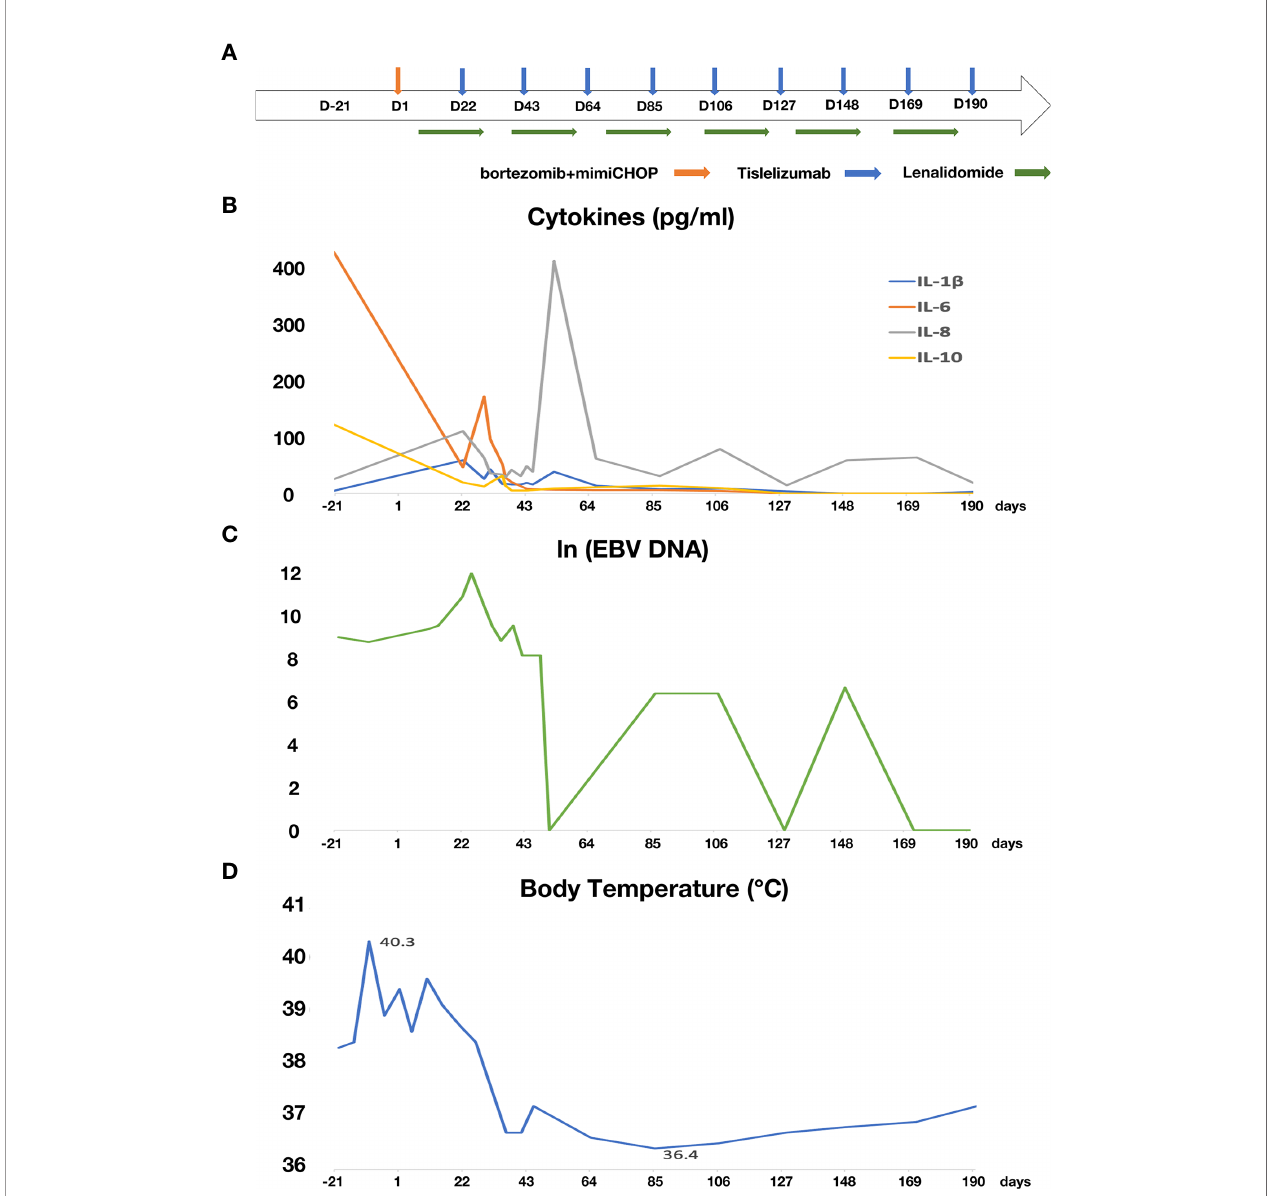
FIGURE 2 | The treatment schedule and the change of cytokines, serum EBV-DNA and body temperature of the patient. (A) Flow chart of treatment; (B) the change of cytokines; (C) the change of EBV-DNA (D) the change of body